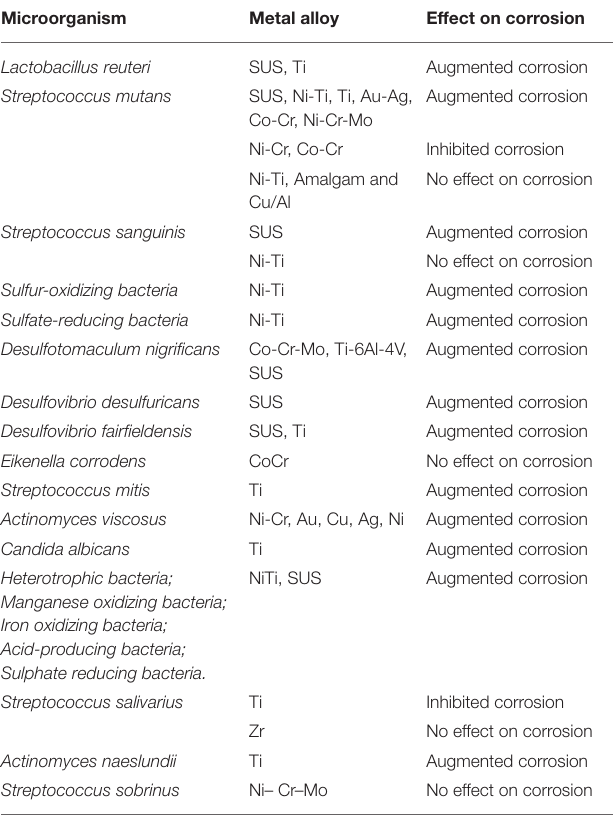
TABLE 3 | Effect of oral microorganism on the corrosion of metal alloy in the included